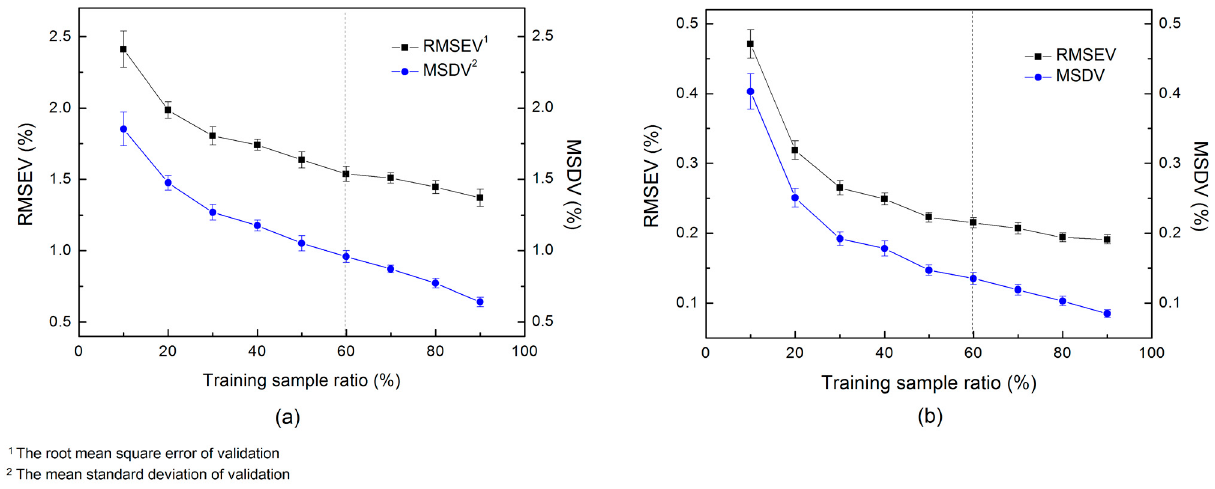
Figure 5. Optimization of the training sample ratio (r s ) for the infant formula adulteration data sets: ( a ) hydrolyzed leather protein (HLP) data set; ( b ) melamine data set.